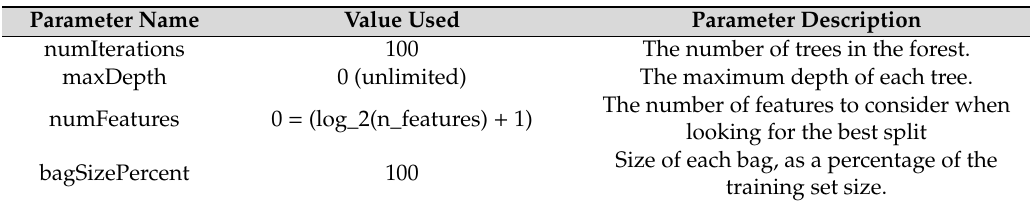
Table A2. The following table lists the essential parameters used in setting up the random forest classifier in Weka. Default values were used for all other parameters not listed in the table.